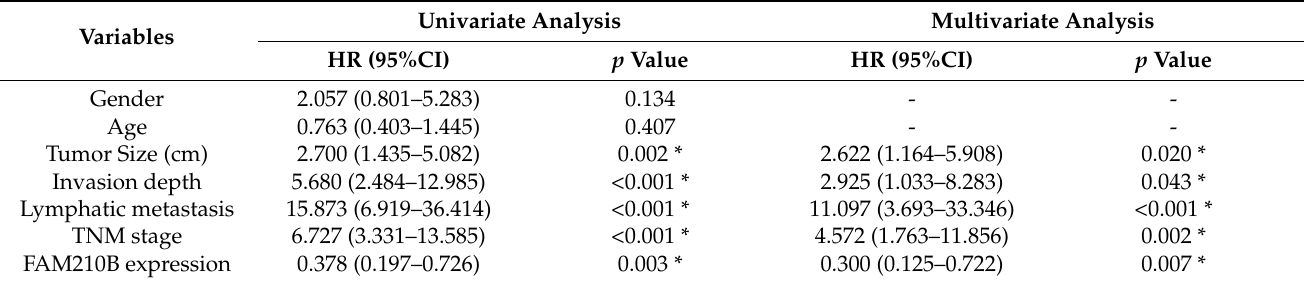
Table 2. Univariate and multivariate analysis of overall survival in 64 patients with HCC by cox regression